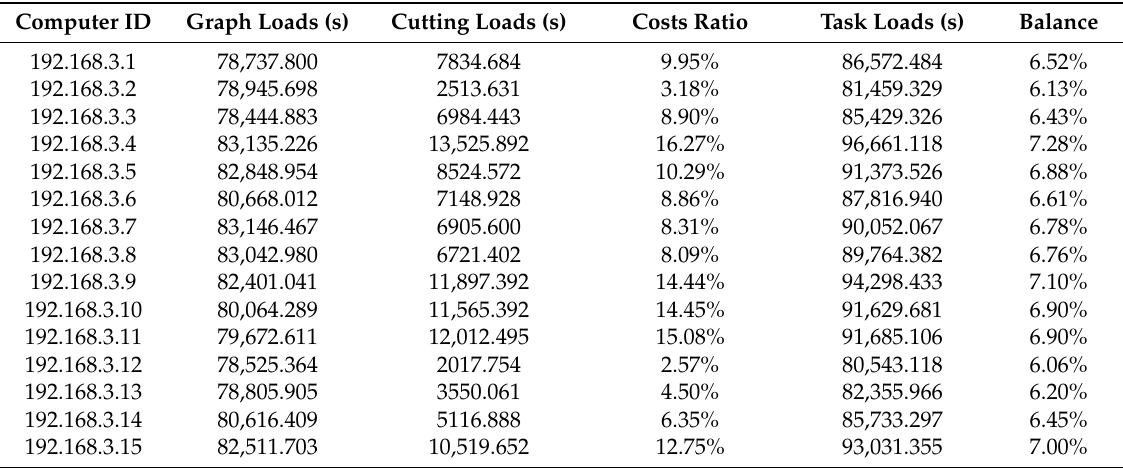
Table 6. Computing time loads for the partitioning domains and total loads.